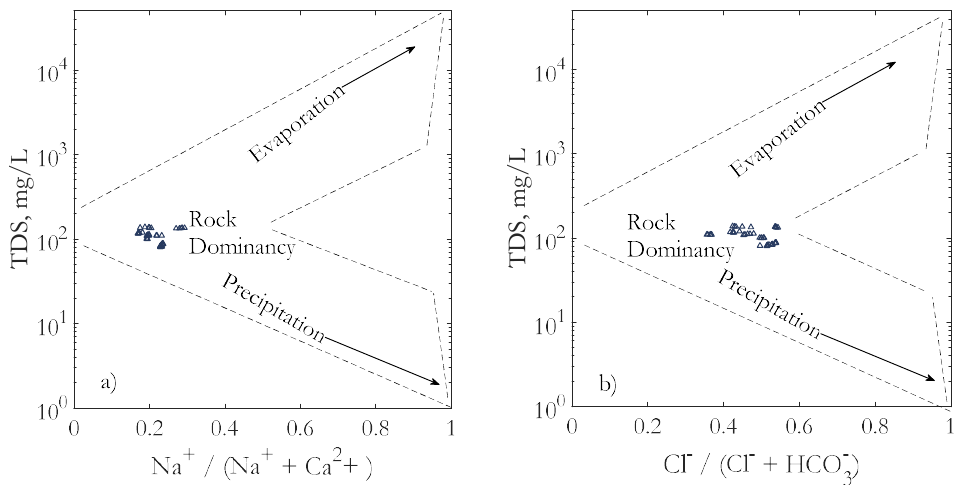
Figure 3. Gibbs diagram relating total dissolved solids (TDS) to ( a ) cations Na + /(Na + + Ca 2+ ) and ( b ) anions Cl − /(Cl − + HCO 3 − ) for the Kanawha River using 45 water samples collected during 2016-2018 (further information in Table S1).